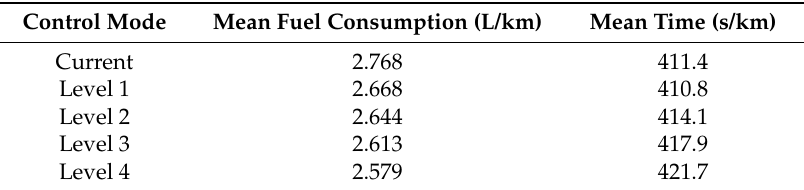
Table 4. Comparison of fuel efficiency and average